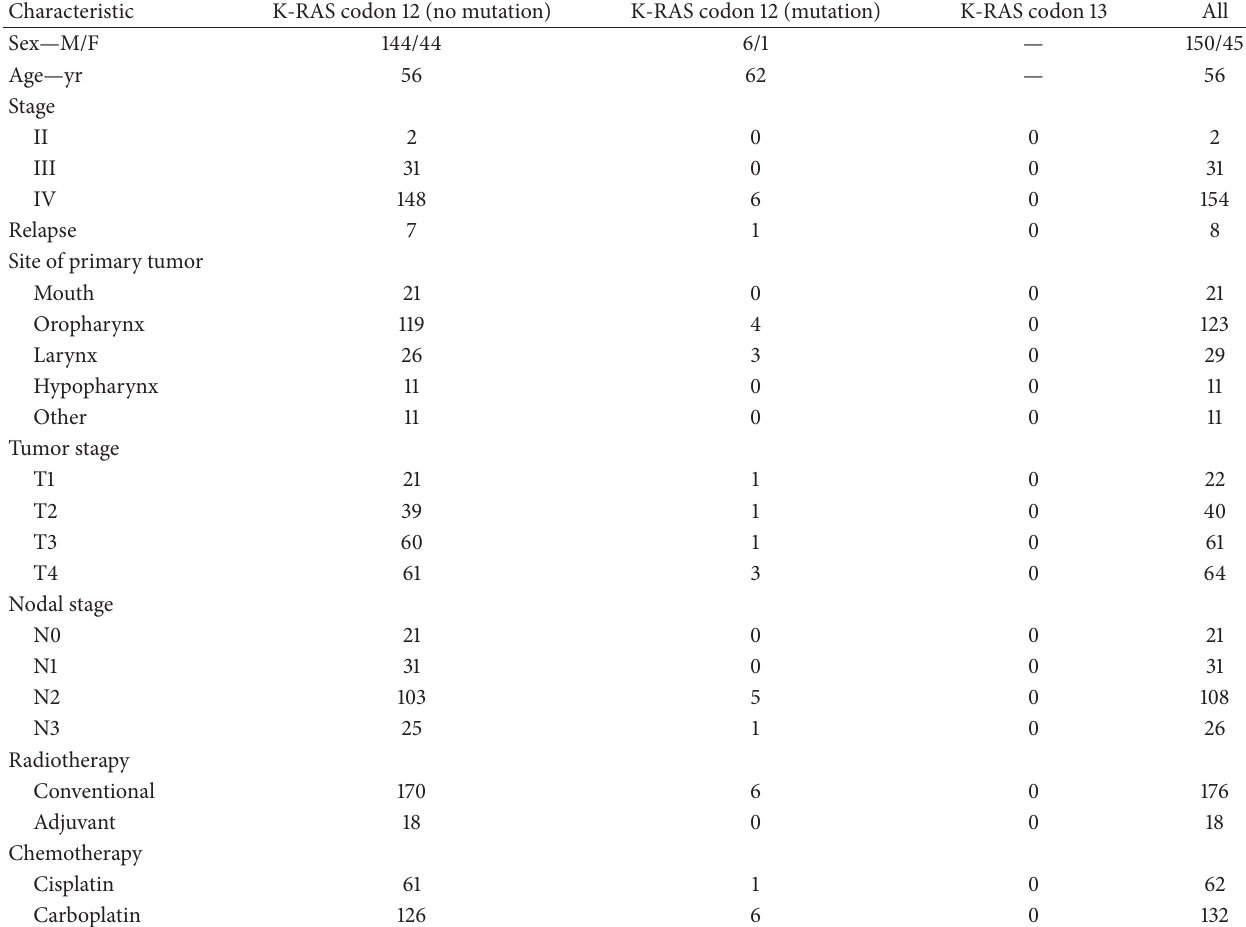
Table 1: Patient characteristics and treatment